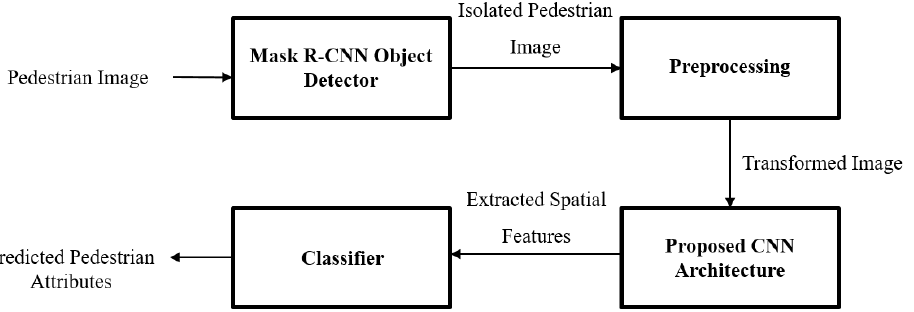
Figure 2. Steps of proposed pedestrian attribute recognition framework.